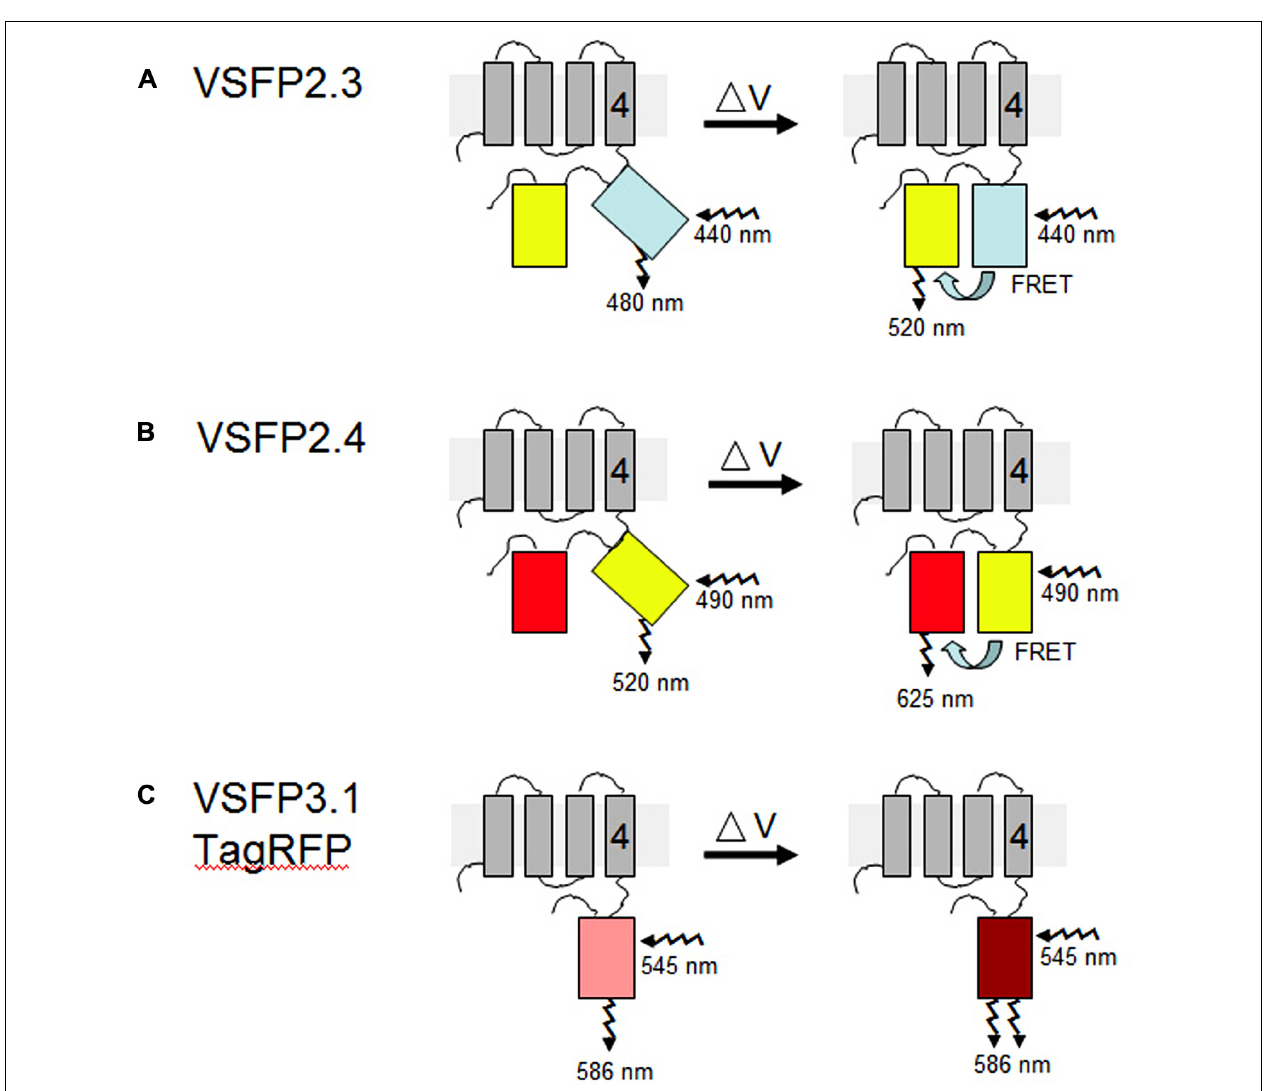
FIGURE 2 |VSFP probes of membrane potential. Different variants of VSFPs contain a combination of a voltage-sensing domain and either a pair of donor and acceptor fluorescent proteins for FRET-based monitoring or a single fluorescent protein for intensity-based recording. One fluorescent protein is attached to the fourth transmembrane segment (gray rectangles, nr. 4) of the C. intestinalis voltage sensor-containing phosphatase (Ci-VSP), which comprises transmembrane motifs S1 to S4 that coordinately operate as the voltage-sensing domain. (A,B) In the two FRET-based systems,VSFP2.3 and VSFP2.4, illumination with the excitation wavelength of the donor protein results in fluorescence primarily at the donor wavelength under resting conditions (left). A change in the membrane potential ( Δ V) allows energy